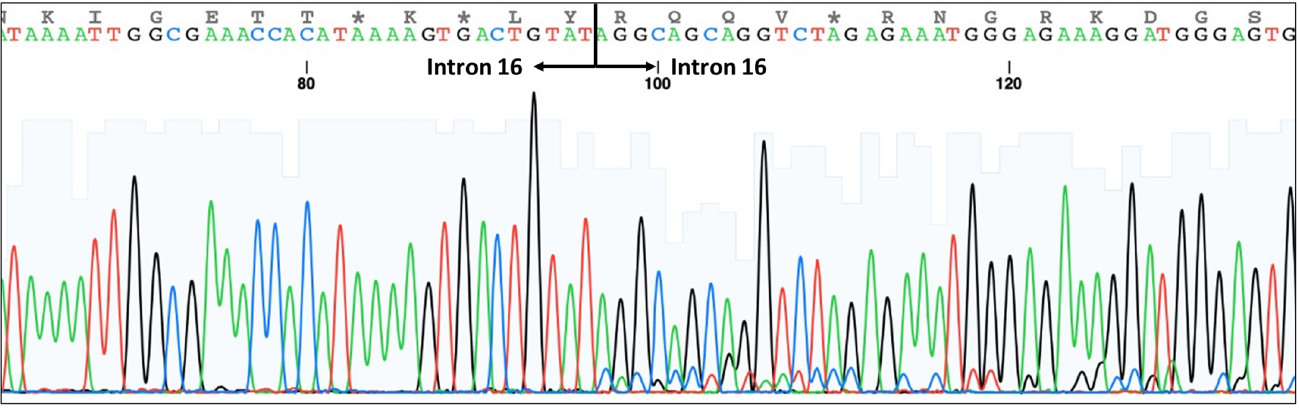
Figure 4. Sequencing results show that samples with DD genotype had deletions in intron 16. Table 5. Results of ACE I/D genotyping in CKD